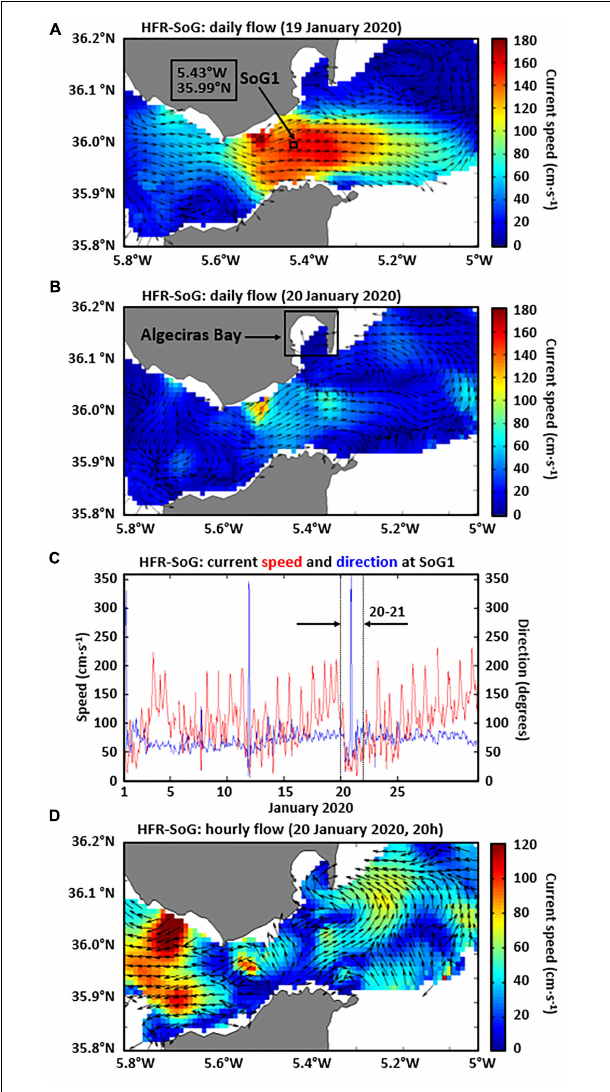
FIGURE 12 | Daily-averaged surface circulation in the Strait of Gibraltar (SoG) as observed with the HFR-SoG system for panel (A) the January 19, 2020 (pre Storm Gloria conditions) and (B) January 20, 2020 (during Storm Gloria); (C) Hourly evolution of surface current speed (red line) and direction (blue line) at SoG1 grid point [denoted in panel (A) ] of the HFR-SoG system during January 2020. Abrupt changes in both parameters during Storm Gloria (20–21) are delimited with a dotted black box; (D) HFR-derived hourly surface circulation for January 20, 2020 (20